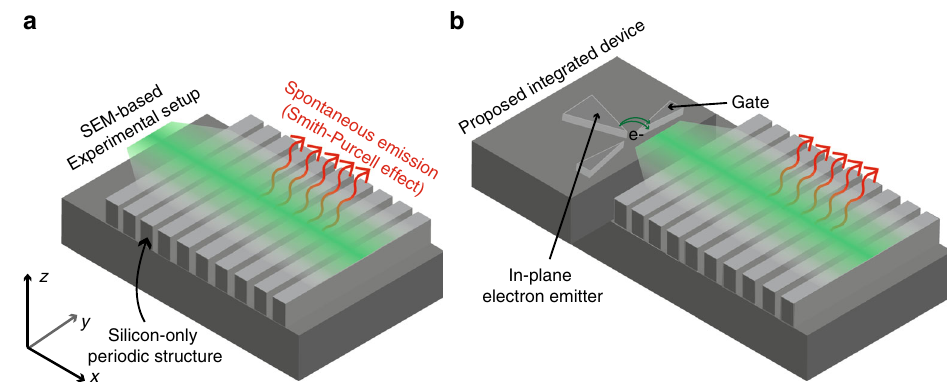
Fig. 1 Broadly tunable radiation from all-silicon nanogratings. a An electron emitter (in vacuum) generates a beam of electrons traveling at a grazing angle to an all-silicon nanograting, thus generating tunable radiation that follows the SP wavelength-angle equation. In our current experimental setup (see Fig. 3), the electron emitter consists of the electron gun of a scanning electron microscope (SEM). b In future devices, the emitter could be integrated onto a silicon chip (see Fig. 4) with, for instance, (gated) silicon fi eld emitter arrays. We discuss the compatibility of this proposed device with